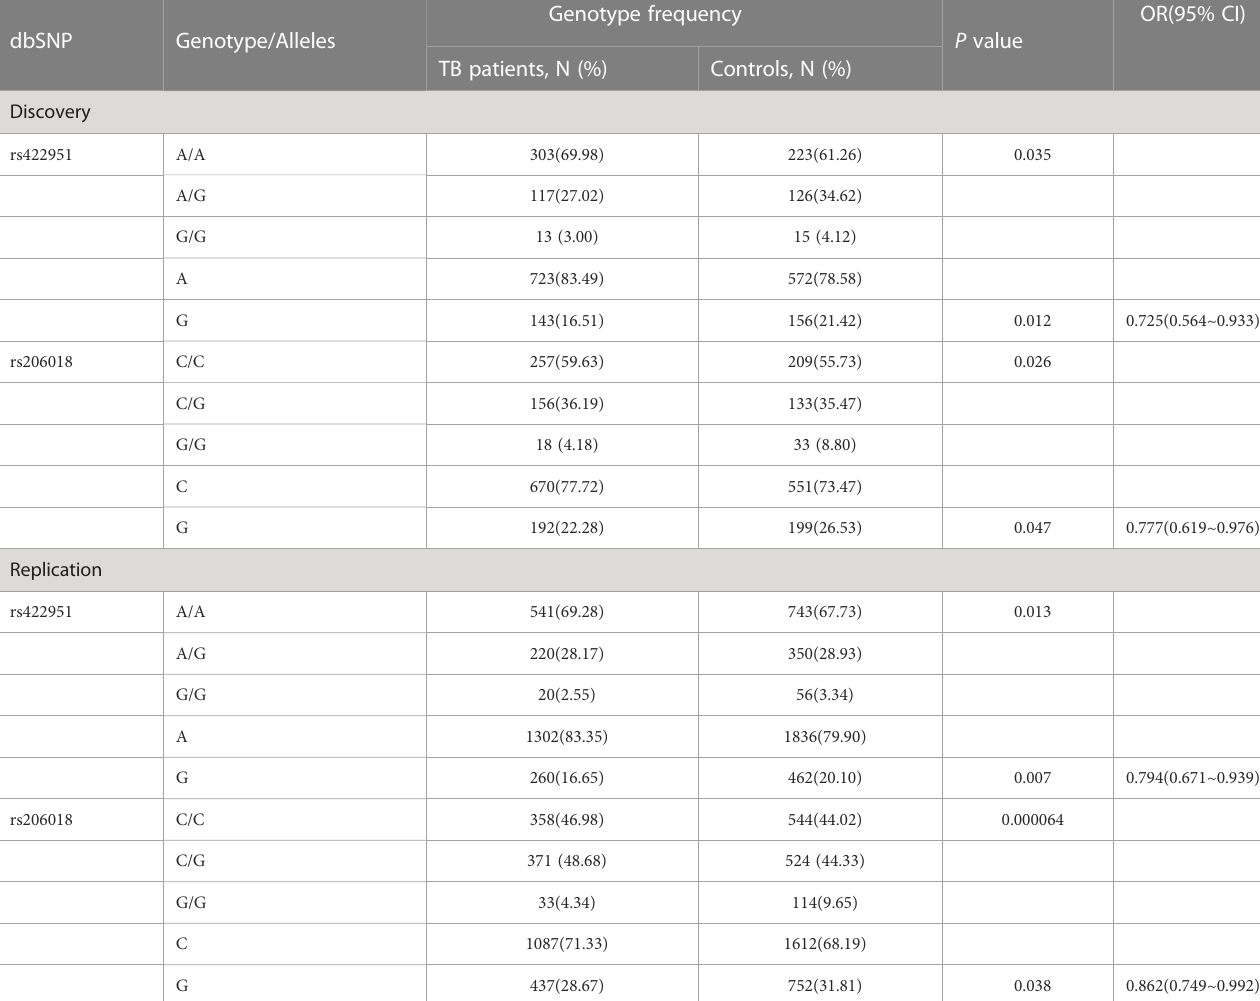
TABLE 1 Genotype and Allele distribution and frequencies of Notch4 gene rs422951and rs206018 in pulmonary tuberculosis patients and